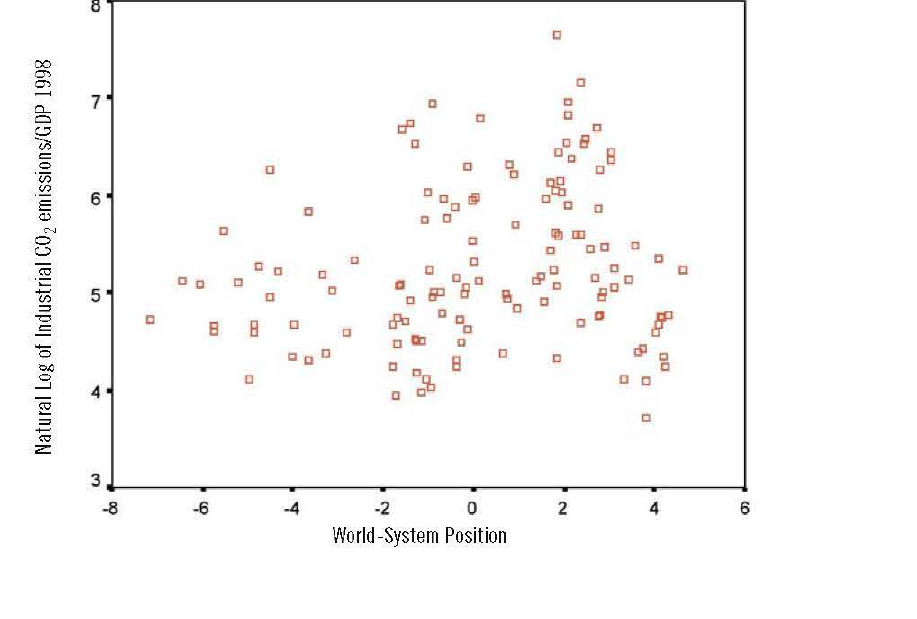
Figure lb: N atural log of national carbon emissions intensity (C0 unit of GDP), 1988, vs. hybrid Terlouw index of posit ion in the world